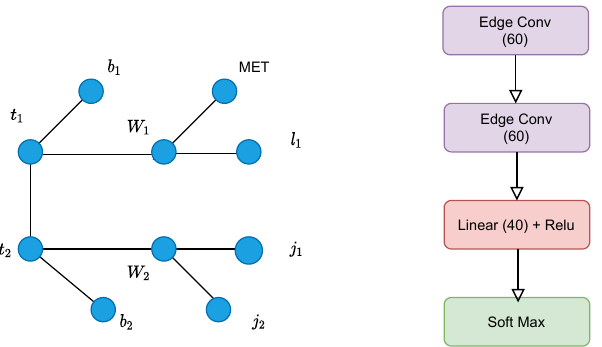
Figure 1 . Representative diagram for the input graph and the network architecture used in this